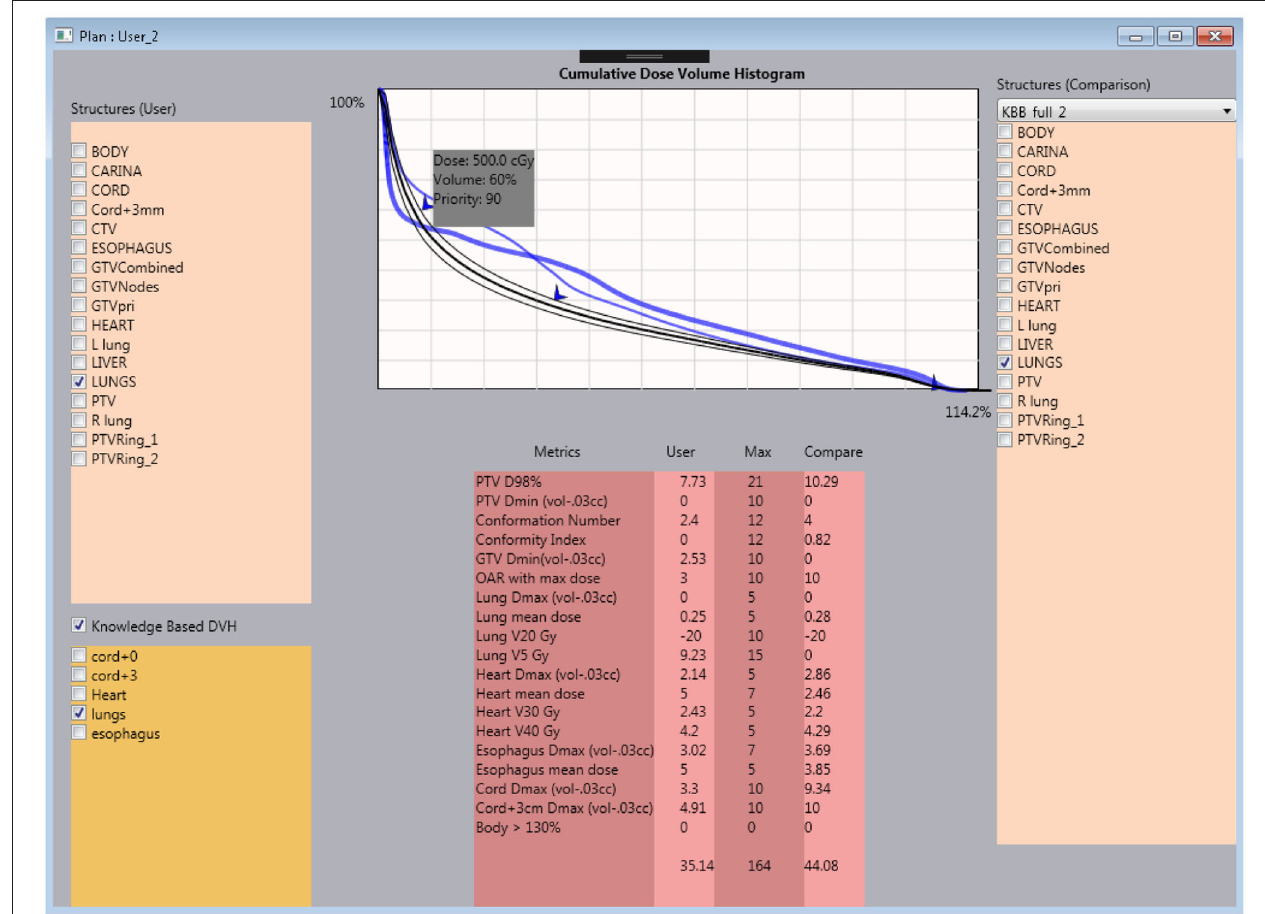
FIGURE 2 | Interactive user interface of the tutoring system. Within the system, the trainee is capable of checking the current plan’s metrics against the clinical plan and knowledge model DVH prediction.